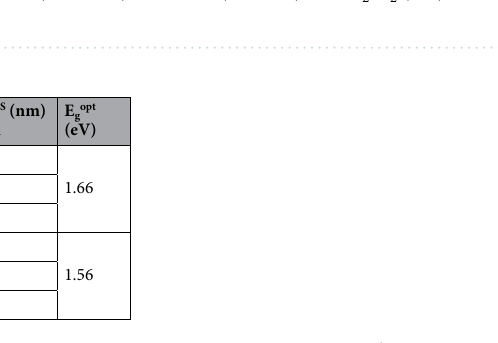
Table 1. Optical data of 1,6-i and 1,7-i recorded in dichloromethane solutions (10 − 6 M) and on glass